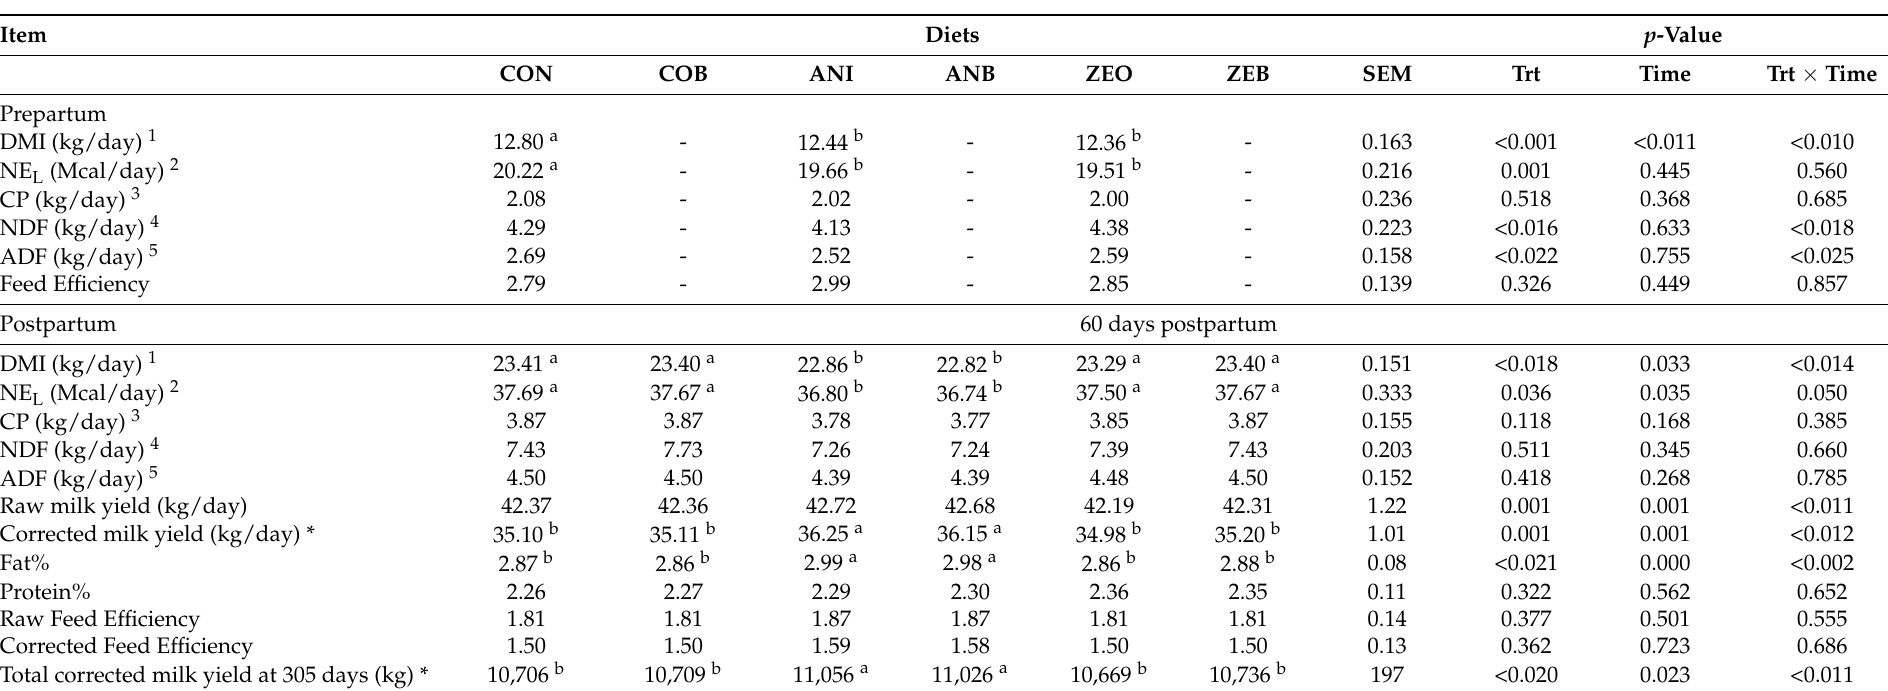
Table 3. Comparison of feed and nutrient intake and milk production traits of experimental diets on day 60 after parturition (kg/day, unless otherwise noted).